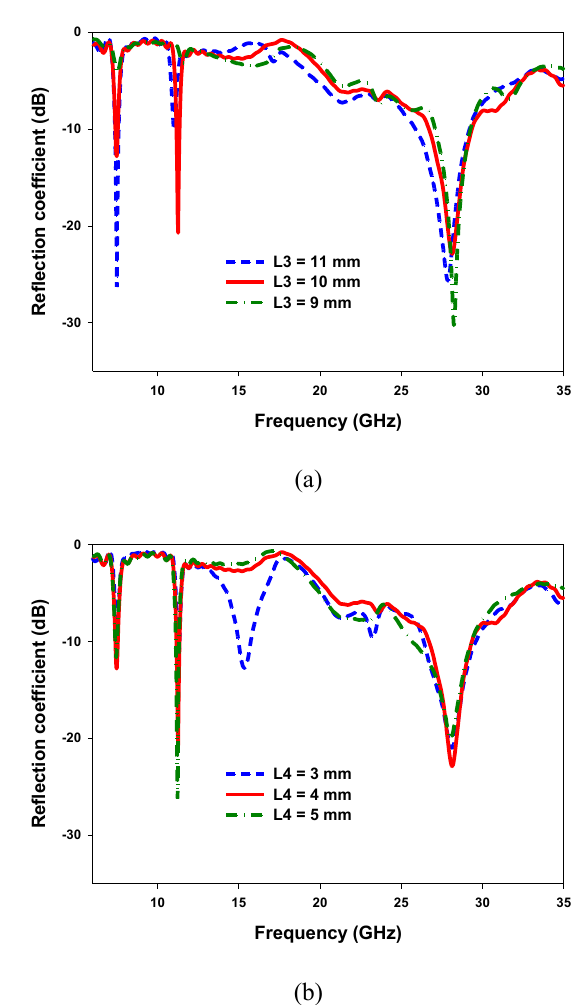
FIGURE 4. Reflection coefficient for various values of (a) L1 and (b) L2 lengths of L_slot 1. Fig. 5 shown the reflection coefficient as a function of lengths of L-Slot 2 L3 and L4. It is clear that an increase in L3 causes a diminution in antenna reflection coefficient and the appearance of a new band. From Fig. 5 (a) we can see that the resonance frequency corresponds to the value L3=10 mm is 28 GHz (the fifth generation band), which is the desired frequency, we maintain this value of L3 and adjust L4 from 3 mm to 5 mm. There is a slight variation in the level of adaptation in Fig. 5 (b). From this figure, we also notice that the second and third bands are adapted, therefore, to better adapt the first resonant frequency we will add a third slot.